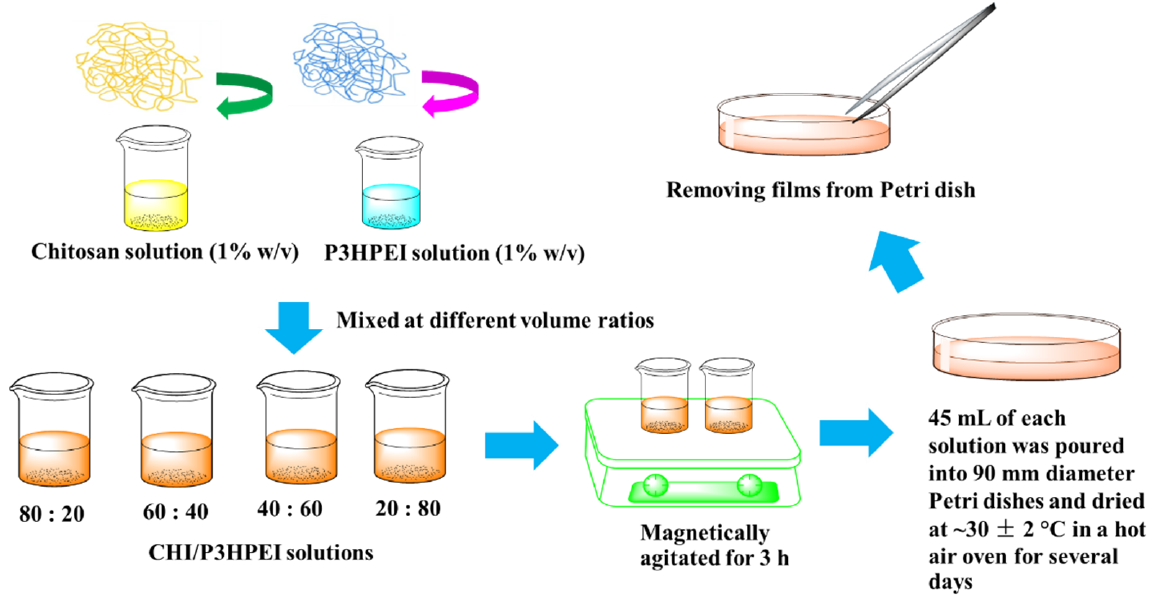
Figure 1. Scheme of CHI/P3HPEI films preparation.